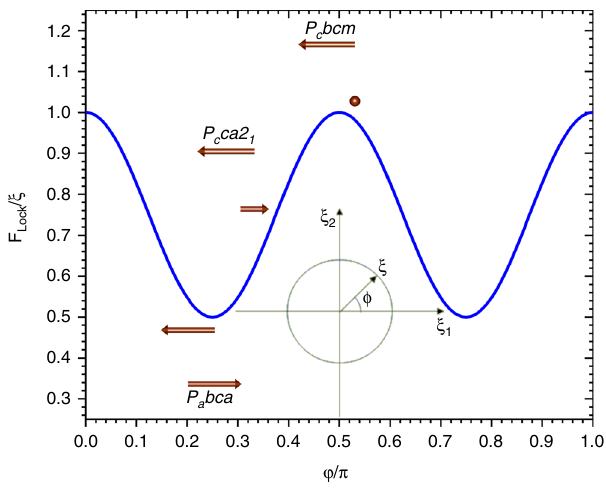
Fig. 9 Phase dependence of the F Lock = ξ 1 4 + ξ 2 4 invariant. The invariant is responsible for the lock in transition and the magnetic phase selection. The arrows indicate the stacking and the relative total moment of the trimeron units along the b directions for the different possible values of the magnetic phases ( π /4, general choice and π /2 going from left to right) corresponding to the different space groups described in the